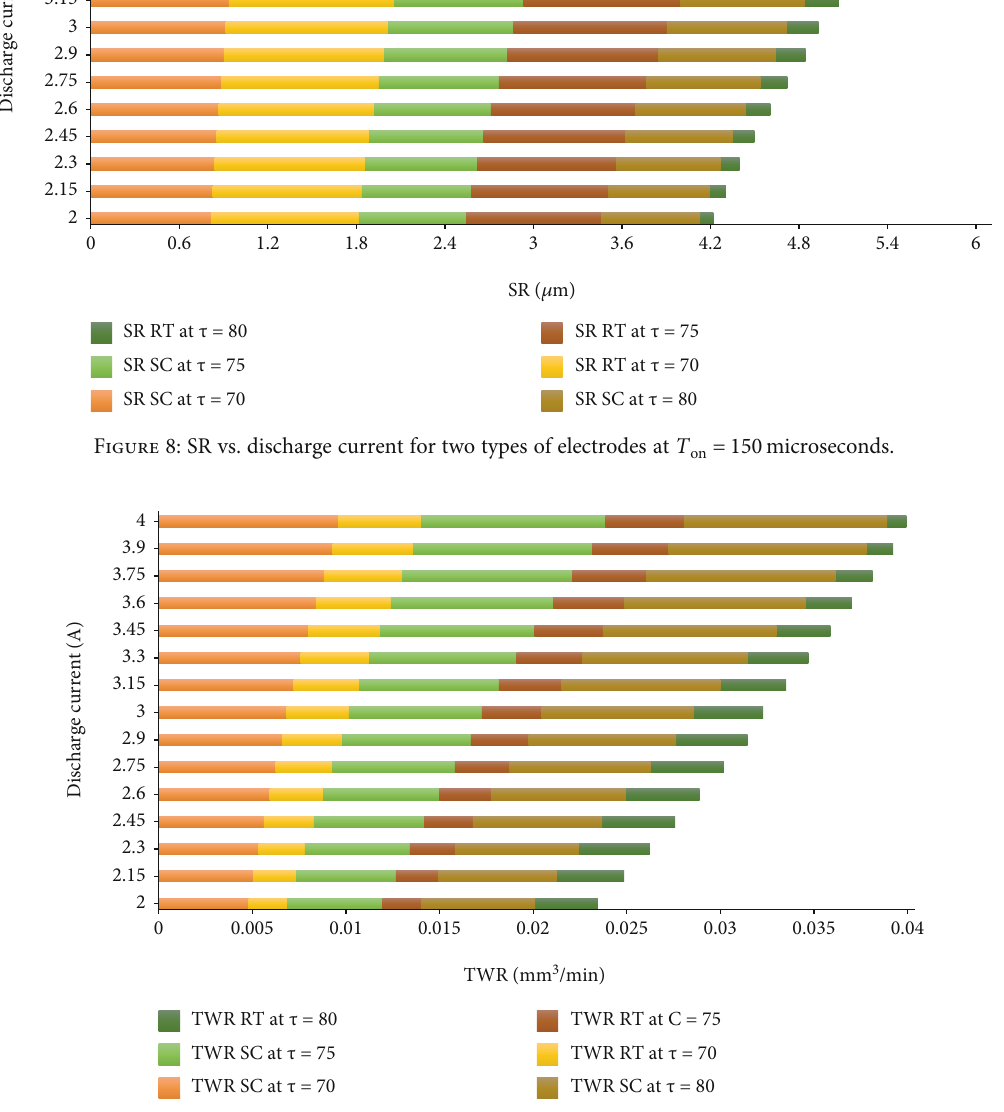
= 50 microseconds on